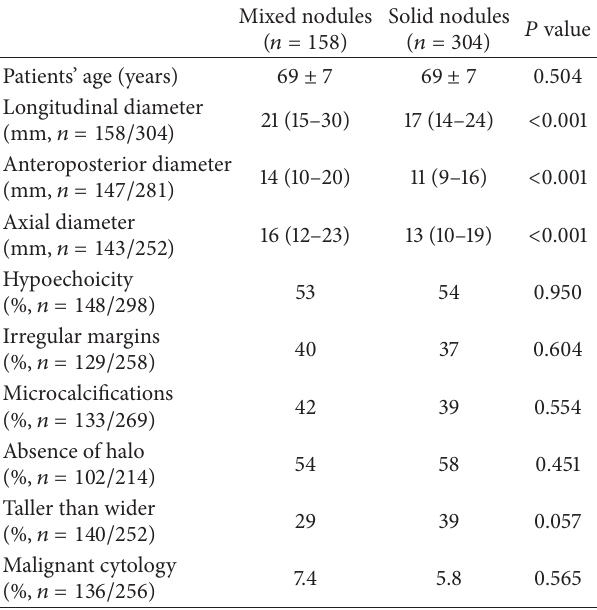
Table 2: General characteristics of mixed and solid